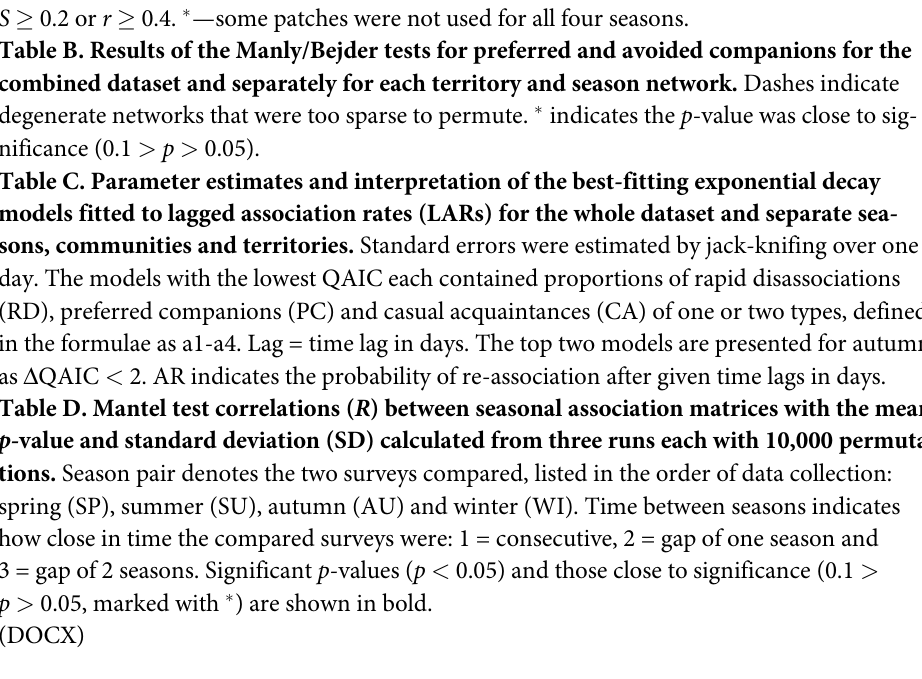
Fig B. The proportion of dyads with simple ratio association indices (SRI) of increasing strength for individuals seen on � 5 days in each season and territory. The proportion of individuals is on the y-axis and SRI, plotted between 0–1, is on the x-axis. Fig C. Proportions of individuals seen on � 5 days in each territory and season with mean (blue) and maximum (yellow) simple ratio association indices (SRI) of increasing strength. Proportion of individuals is on the y-axis and SRI, plotted between 0–1, is on the x-axis. Fig D. The probability that pairs of foxes that associated on a given day would re-associate at a later time (lagged association rate, LAR) within communities 1–7, and the expected association rate if associations were random (null association rate, NAR) calculated across all data. Vertical lines show jack-knife standard errors. Fig E. The probability that pairs of foxes that associated on a given day would re-associate at a later time (lagged association rate, LAR) within each territory, and the expected asso- ciation rate if associations were random (null association rate, NAR) calculated across all data. Vertical lines show jack-knife standard errors.